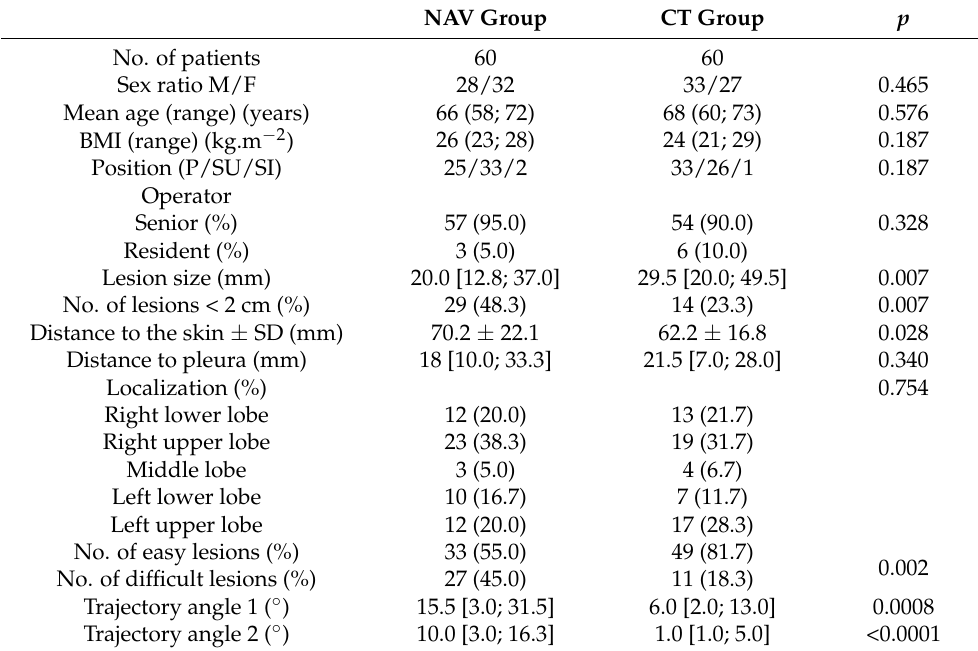
Table 1. Characteristics of the patients and the